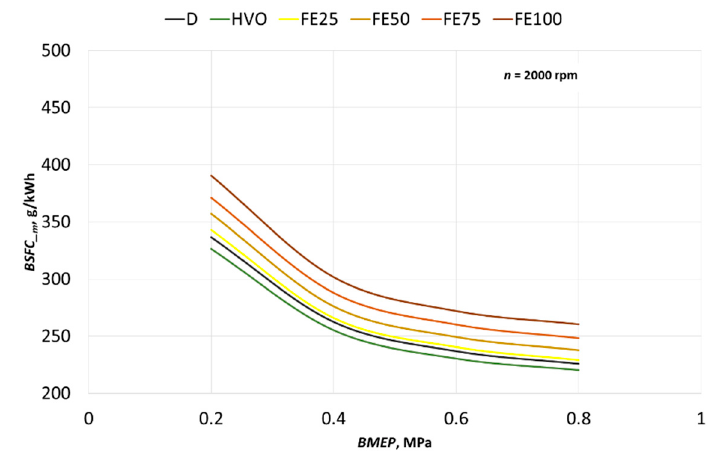
Figure 6. Dependence of BSFC_m, g/kWh on the load.